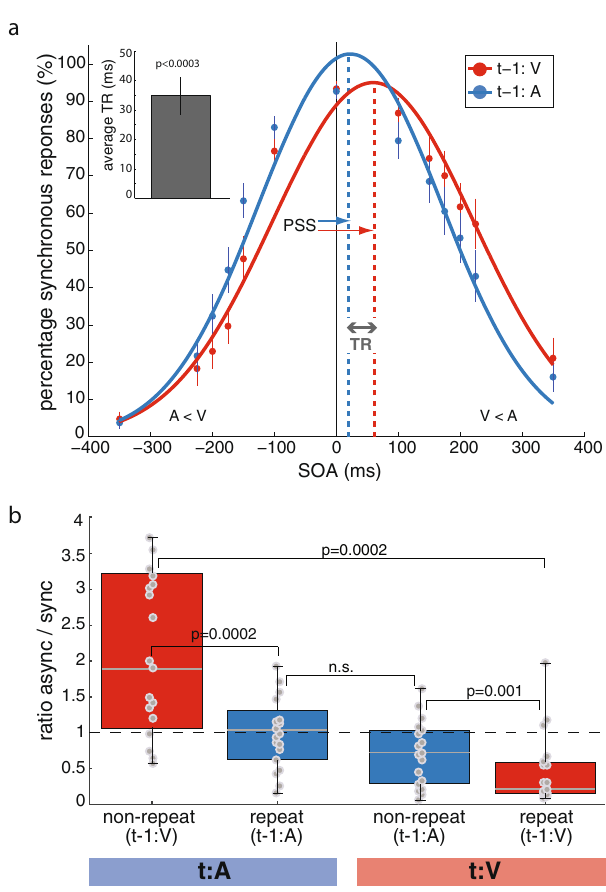
Fig. 2 Behavioral performances. a Synchronous responses as a function of stimulus onset asynchrony. Psychometric curves (Gaussian model adjusted to behavioral measures) showing the percentages of synchronous responses as a function of SOA for trials with visual lead on the previous trial (t-1:V, red) and those with auditory lead (t-1:A, blue). Dots represent average behavioral reports across participants ( n = 18). The colored thin lines indicate the standard errors of the mean (SEM). Inset: mean temporal recalibration (TR) estimate and SEM across participants evaluated against zero with a two-tailed, one-sample t test. b Individual ratios of asynchronous-to-synchronous responses for all trial con fi gurations. Ratios of asynchronous to synchronous responses across participants for all t-1/t trial combinations, i.e. auditory or visual lead on trial t (t:A or t:V) paired with visual or auditory lead on the previous trial (t-1:V and t-1:A). The lower and upper limits of the red and blue boxes represent the interquartile range (quartiles Q1 and Q3); gray center lines denote Q2 (median); whiskers represent minimal and maximal data points; gray dots represent single- subject data ( n = 18). The dashed black horizontal line highlights a ratio of 1. Wilcoxon signed-rank tests were performed between all trial combinations; n.s.: p > 0.0125 after accounting for multiple